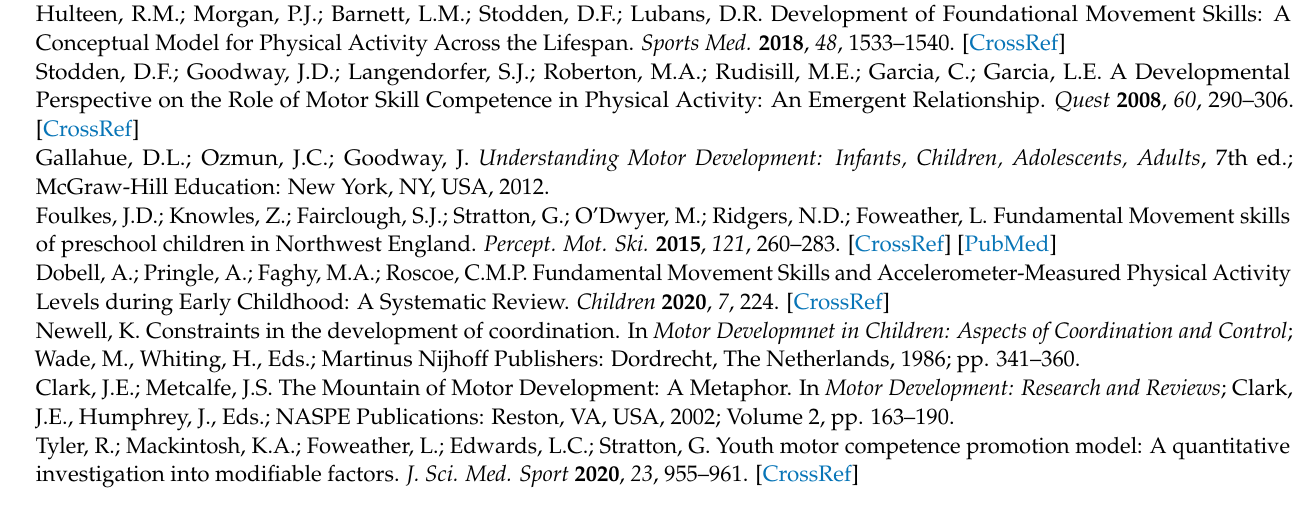
activity levels; Table S2: Table reporting variation matrices of time spent in different group sizes; Table S3: Table reporting variation matrices of time spent in different activity